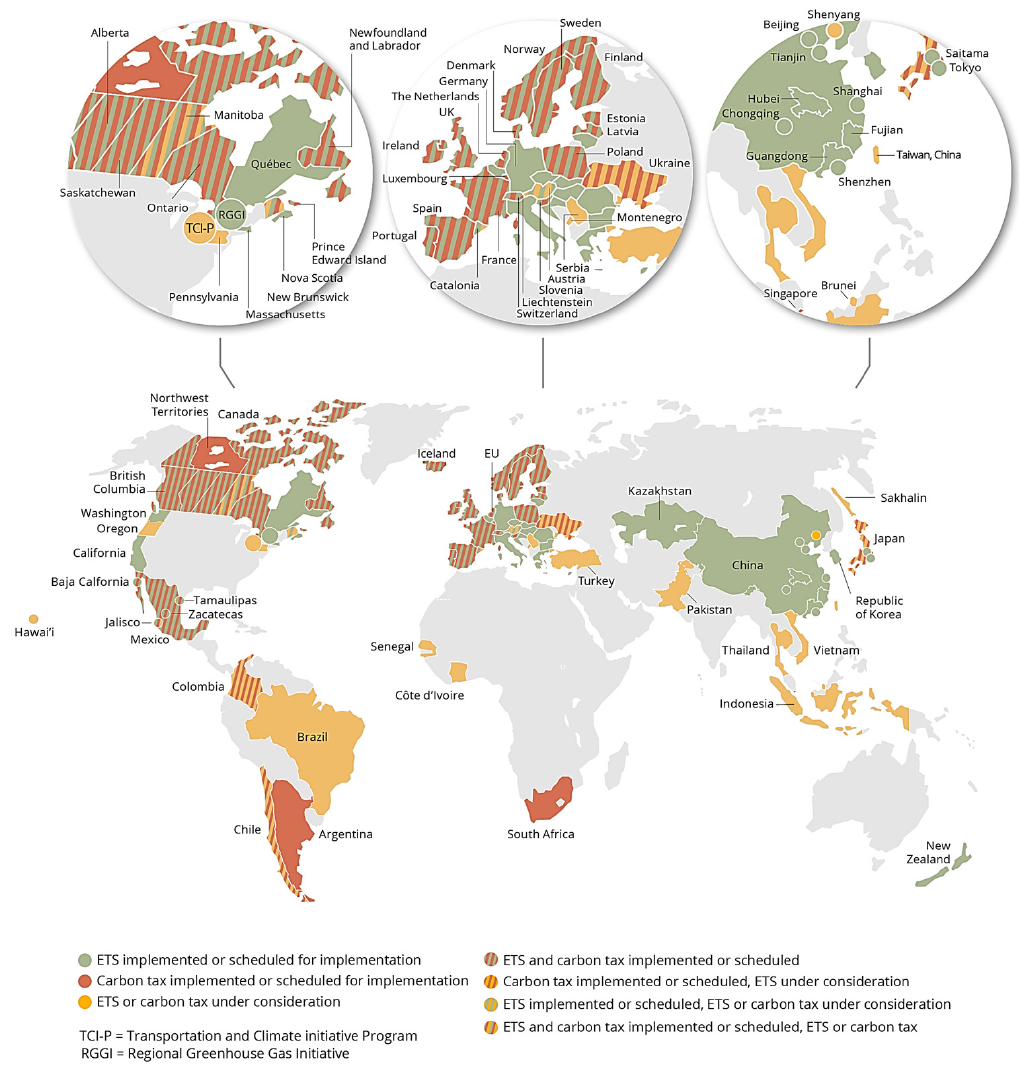
Figure 13. “Global depiction of rules and taxes implemented at July 2022”, reproduced from [36].